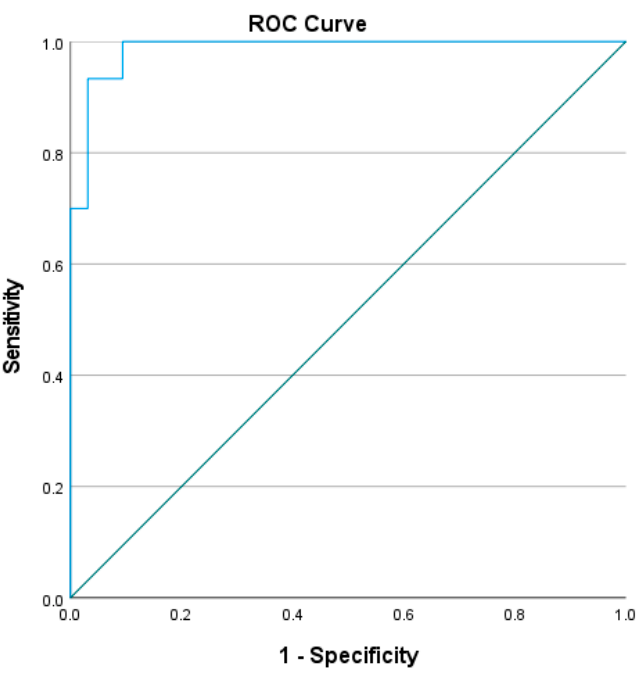
Figure 6. ROC curve of the L Test completion times involving turning towards the paretic side for the 90 ◦ and then turning towards the paretic side for the 180 ◦ (AUC = 98.6%, sensitivity = 100%, specificity = 90.6%, p <